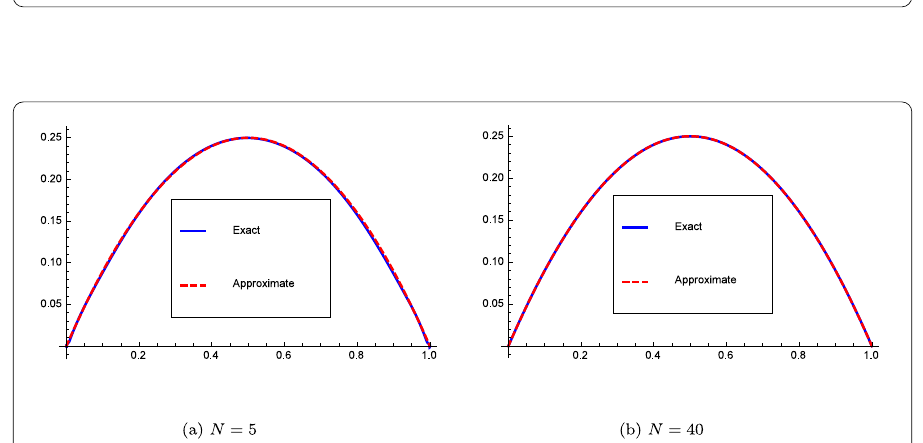
Figure 2 Graphs of exact and approximate solutions for v in Example